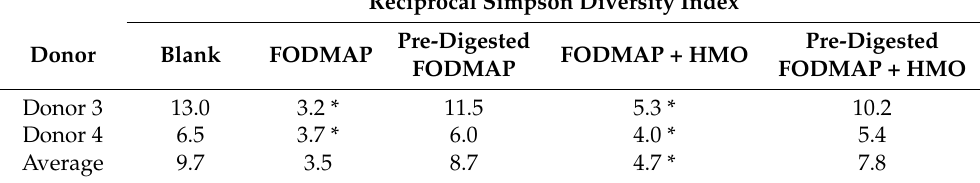
Table 2. Microbial diversity in the transverse